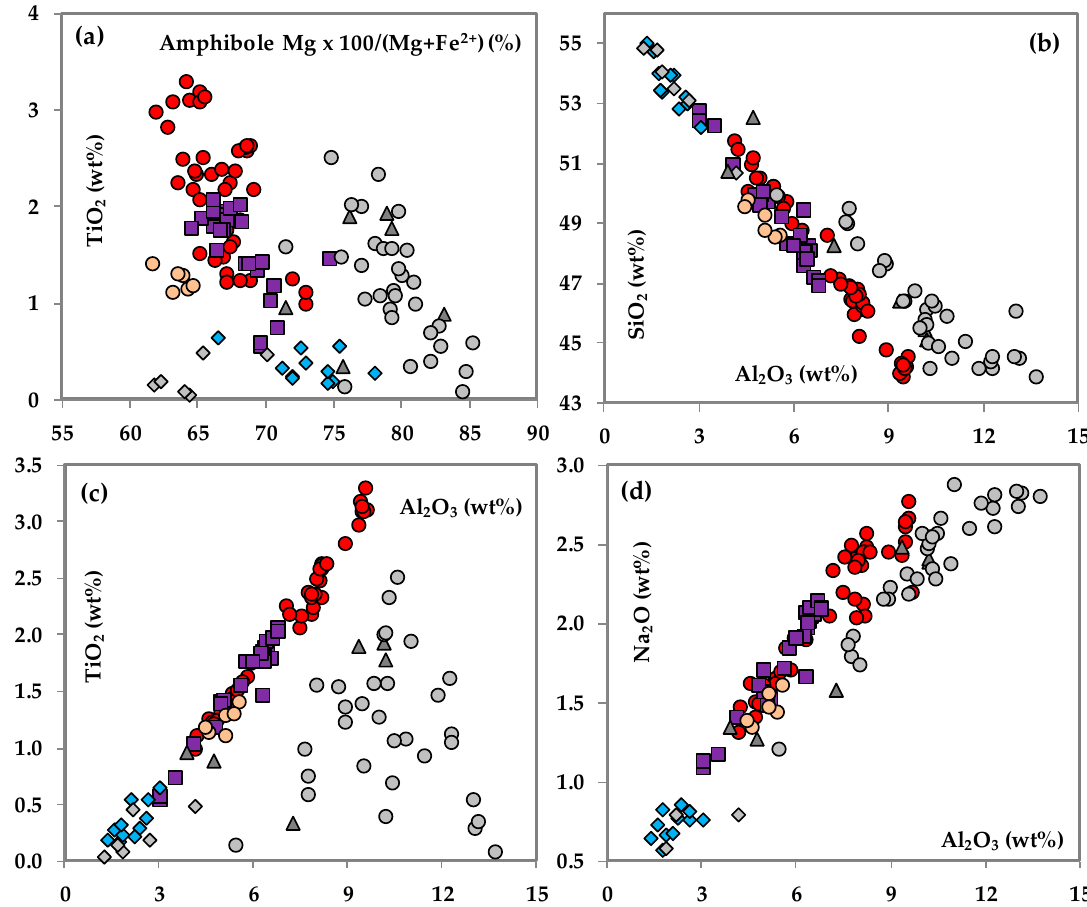
Figure 15. Major and minor element compositions of the amphiboles—Hole U1473A. ( a ) Amphibole Mg# (100 × Mg/(Mg + Fe 2+ ) versus TiO 2 . ( b ) Al 2 O 3 versus SiO 2 . ( c ) Al 2 O 3 versus TiO 2 . ( d ) Al 2 O 3 versus Na 2 O. Symbols are the same as those in Figure 14. Unpublished data from Du Khac Nguyen during Ph.D. course of study at Kanazawa University.